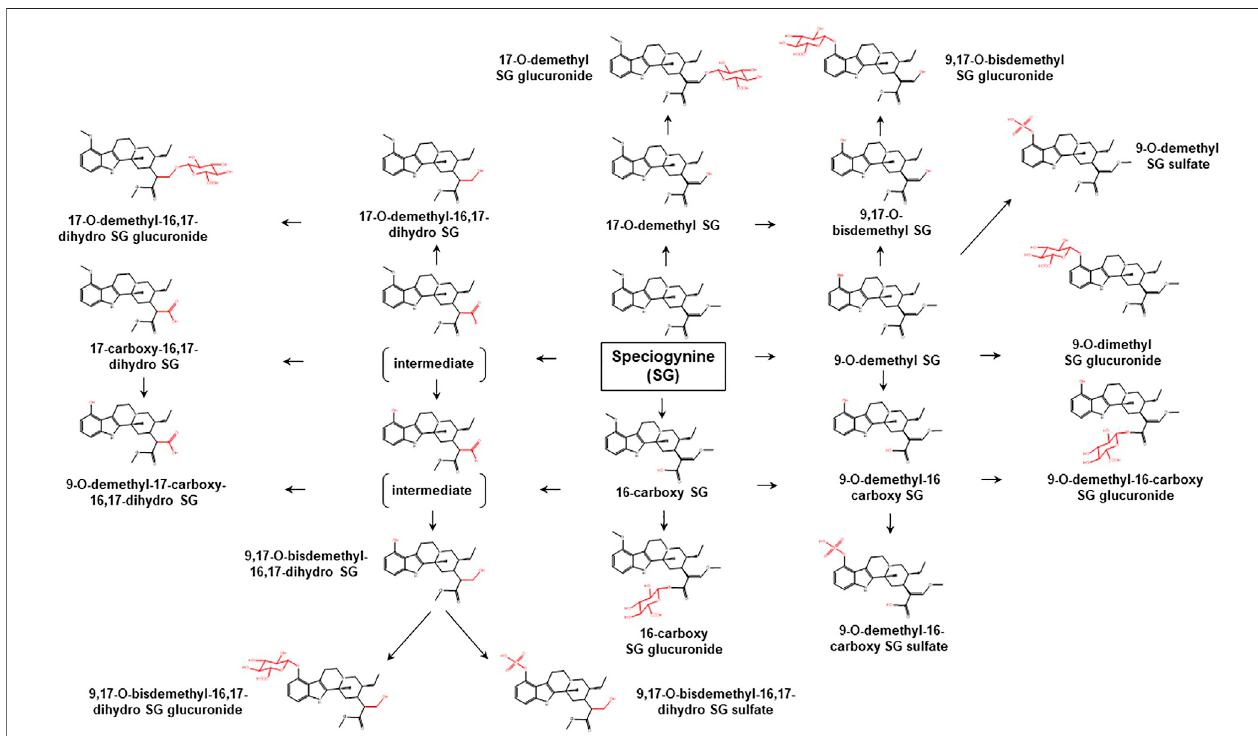
FIGURE 4 | Proposed metabolic pathways of SG based on data obtained in rodents and humans. Structures highlighted in red denote structural transformation from parent molecule SG. Figure was modi fi ed from Philipp et al. (2010b).